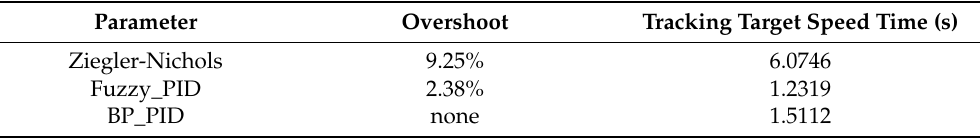
Table 2. Comparison of parameters of different control methods .